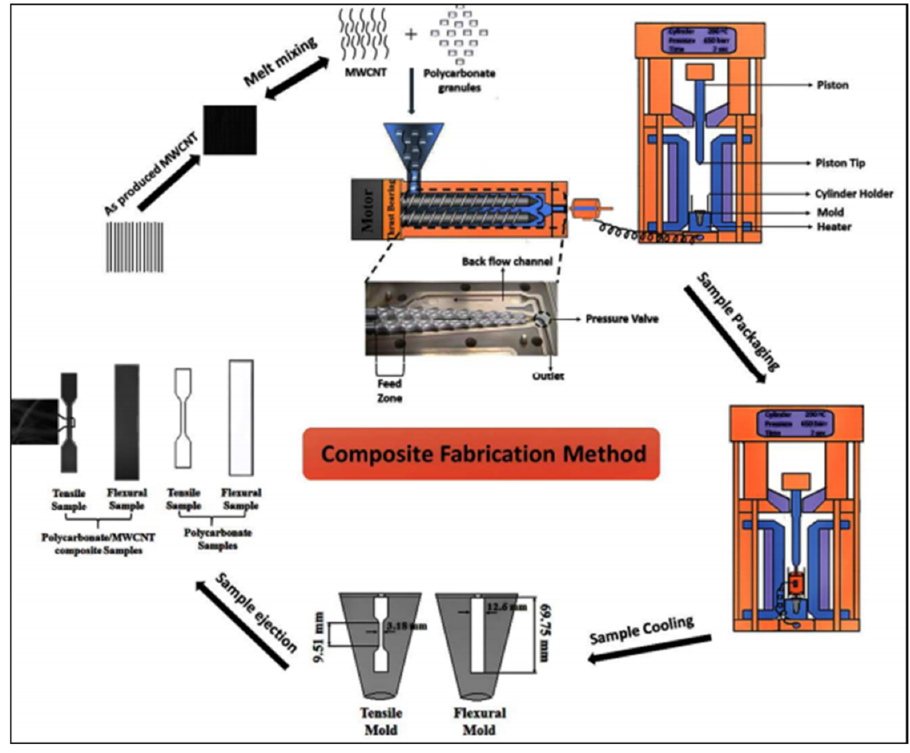
Figure 7. Synthesis of polymer nanocomposites by twin extrusion and injection moulding